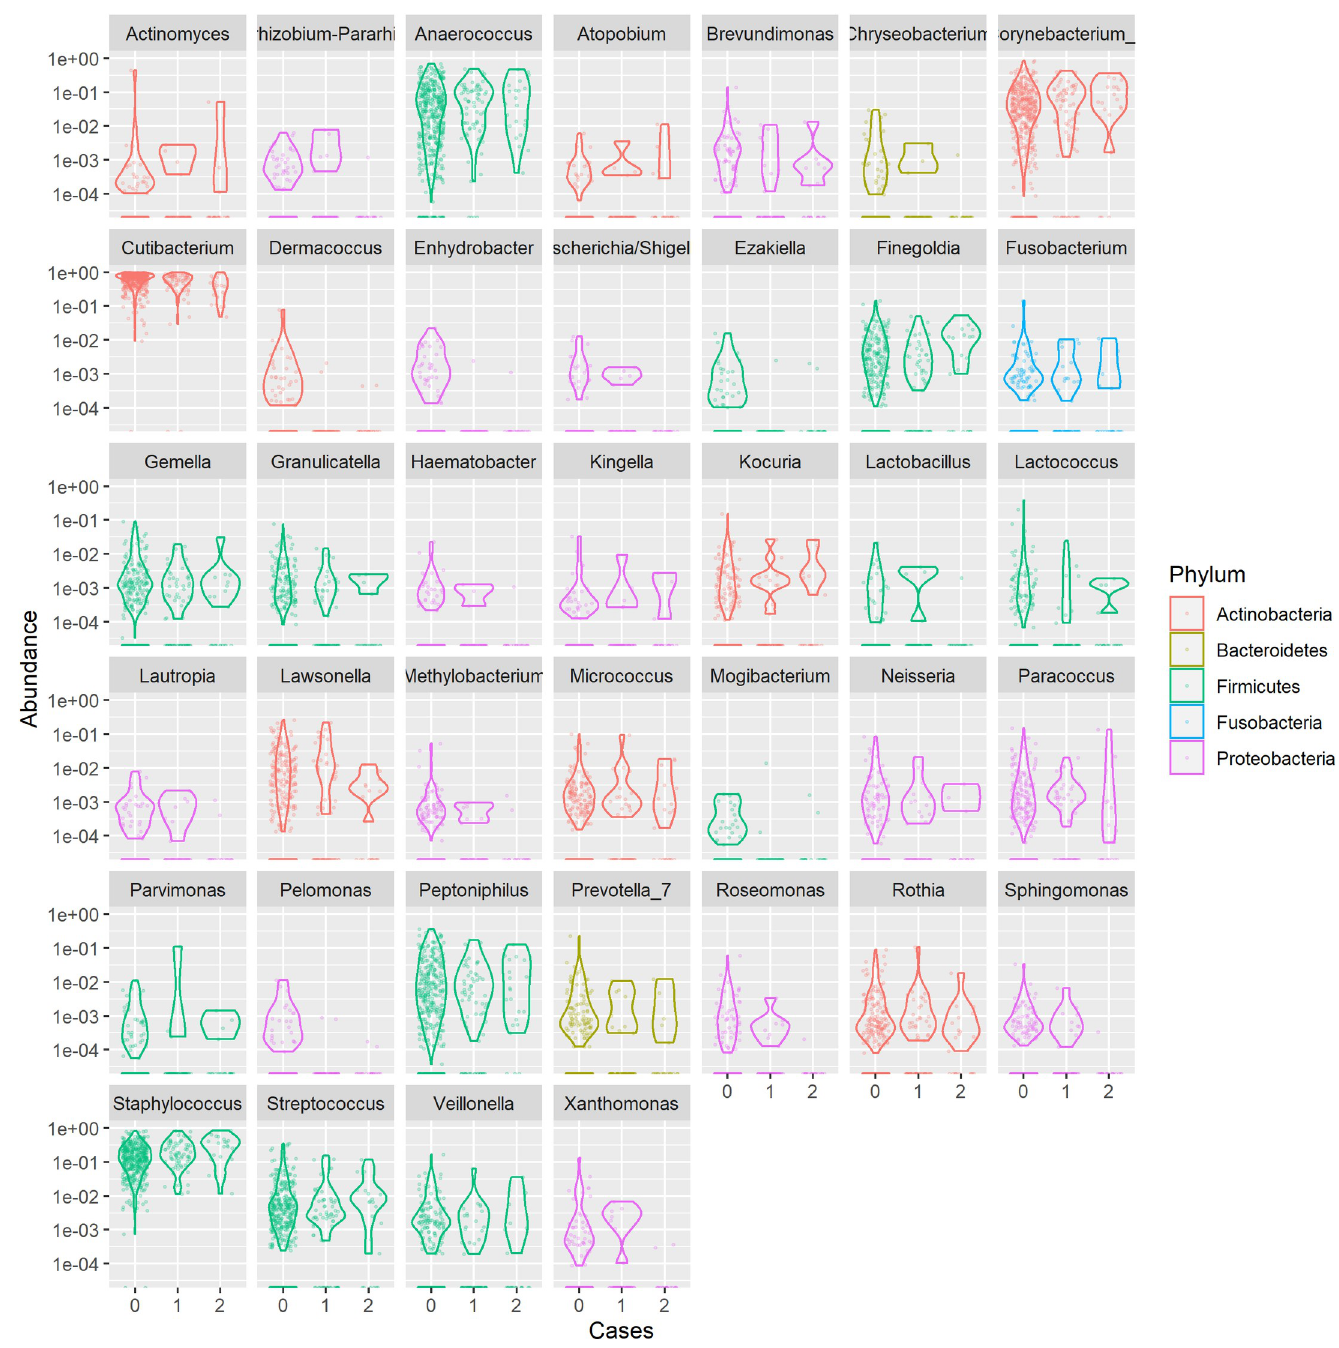
Fig 2. Barplot of relative frequency of genera per phylum. The relative abundance of main genera is presented separately, with controls = 0, non-lesional cases = 1 and lesional cases = 2. Only Corynebacterium _ 1 was nominally significantly different between lesional SD versus controls. https://doi.org/10.1371/journal.pone.0251136.g002 controls; adjusted p-value = 2.4x10 -4 ; lesional cases vs non-lesional cases; adjusted p-value = 0.03; non-lesional cases versus controls: adjusted p-value = 0.03). Since alpha diversity parame- ters are sensitive to differences in sample library size, we evaluated the impact of different fil- tering thresholds as well as rarefaction (S1 File). As shown in the S3–S5 Figs, alpha diversity